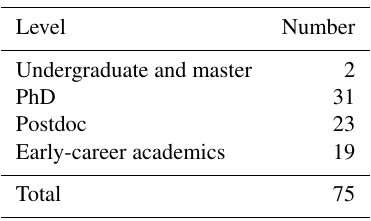
Table 2. List of academic levels of the participants (including the project